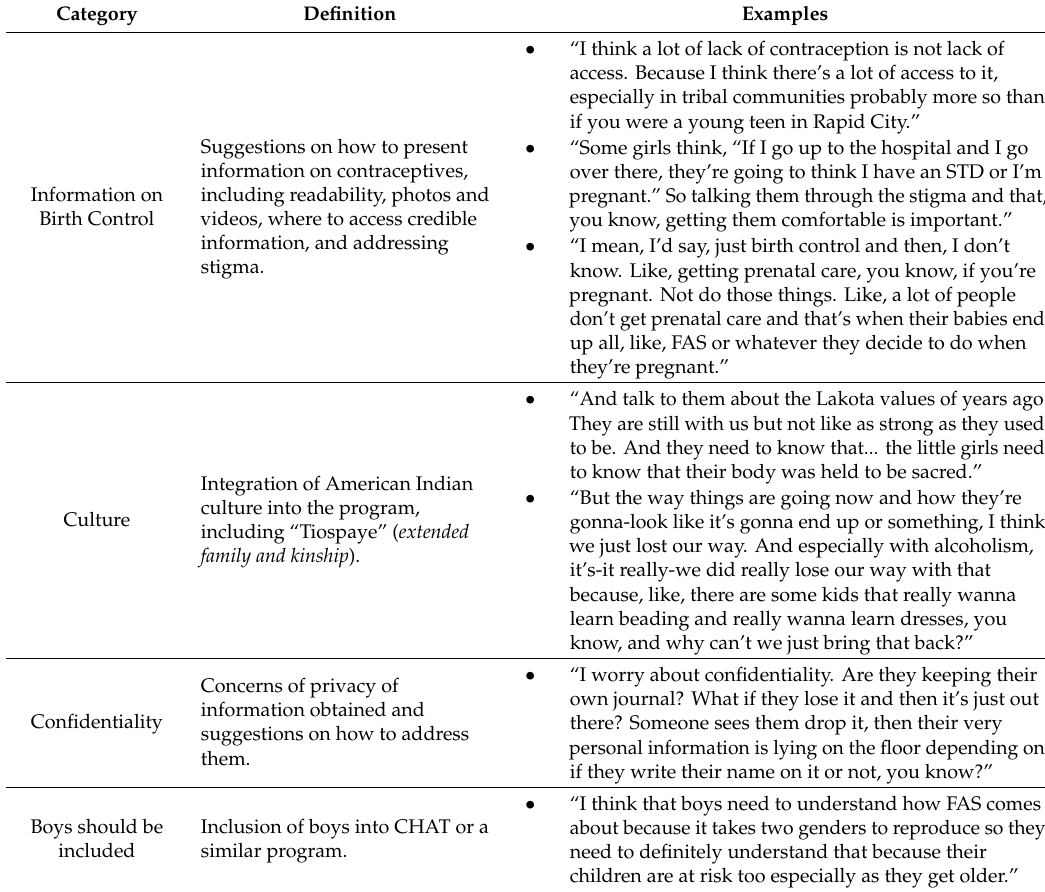
Table 1. Summary of